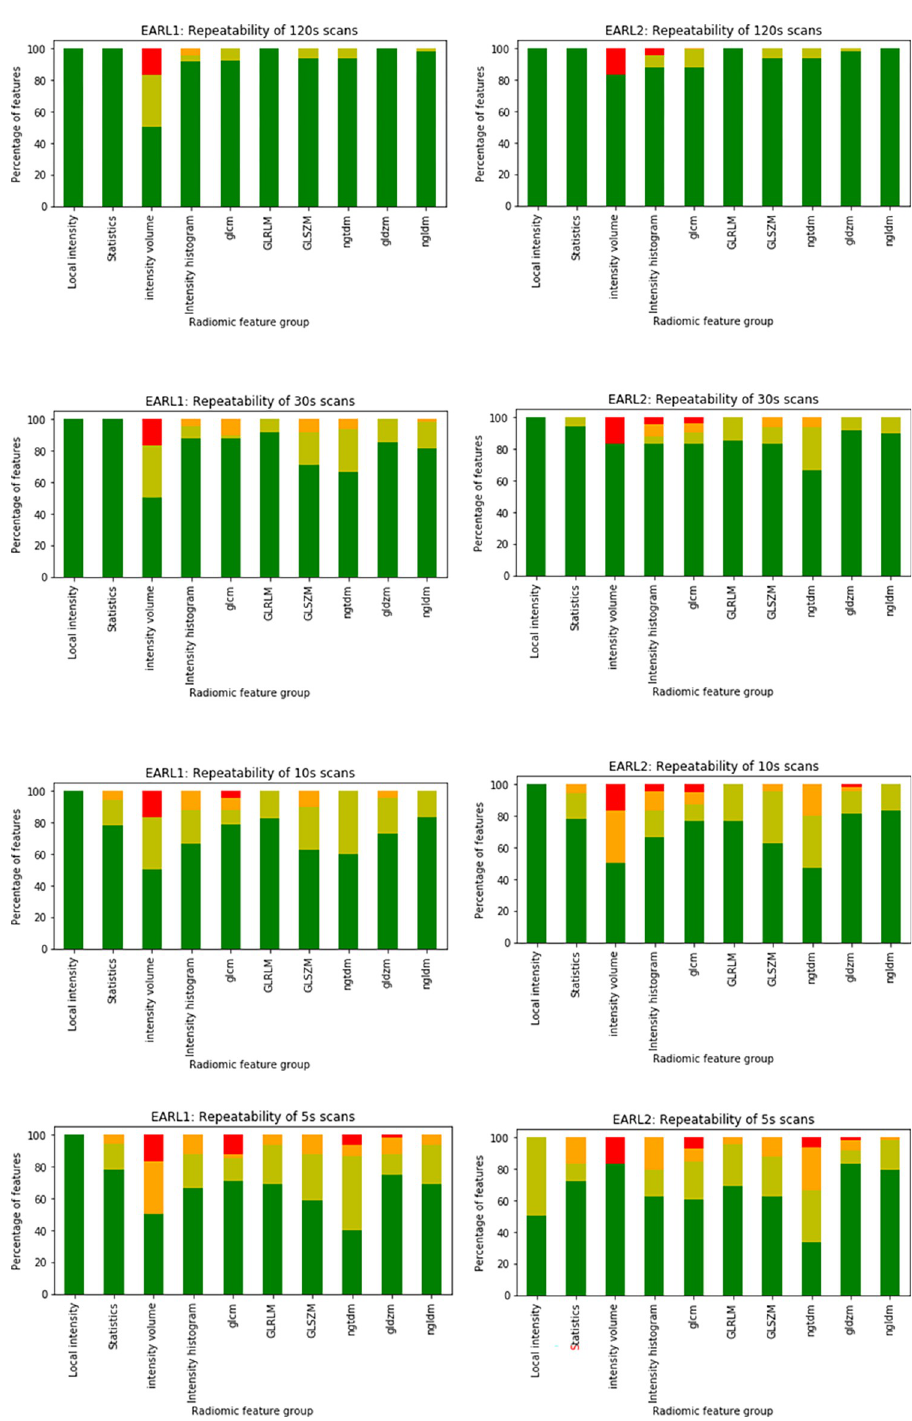
Fig 3. Percentage of features in each ICC category (dark green: Excellent ICC, light green: Good ICC, orange: Moderate ICC, red: Poor ICC) per feature group for different scan durations (from top to bottom: 120 s, 30 s, 10 s, 5 s) for EARL1 (left) and EARL2 (right) reconstructed